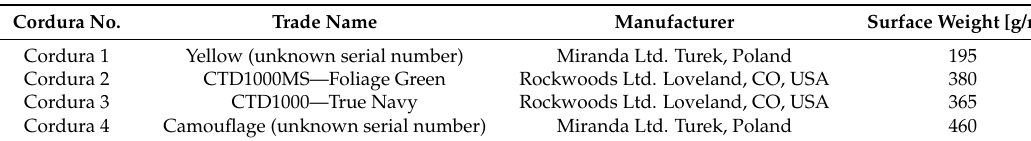
Table 1. Characteristics of Cordura samples.